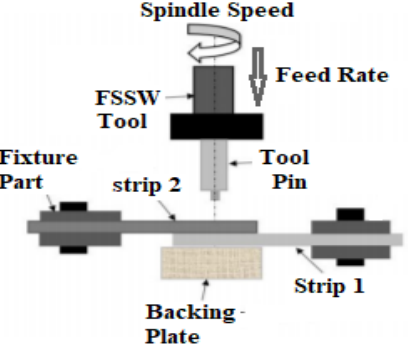
Figure 4. Schematic representation of friction sir spot welding process. Ninety experiments were performed with different values of SS, FR, and PD to study the influence of welding parameters on FSSW strength. Values of FR, SS, and PD during